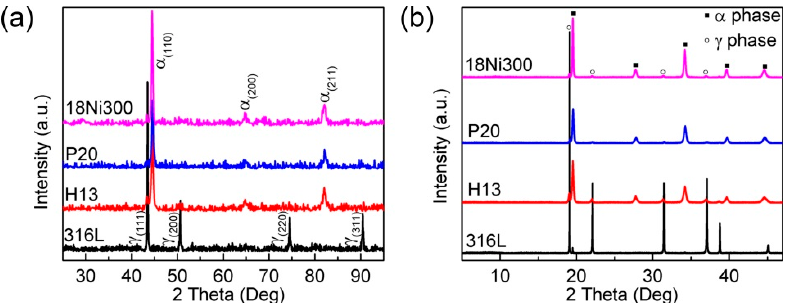
Figure 2. ( a ) X-ray diffraction (XRD) and ( b ) synchrotron radiation X-ray diffraction (SR-XRD) results of four steel powders in the as-received state.